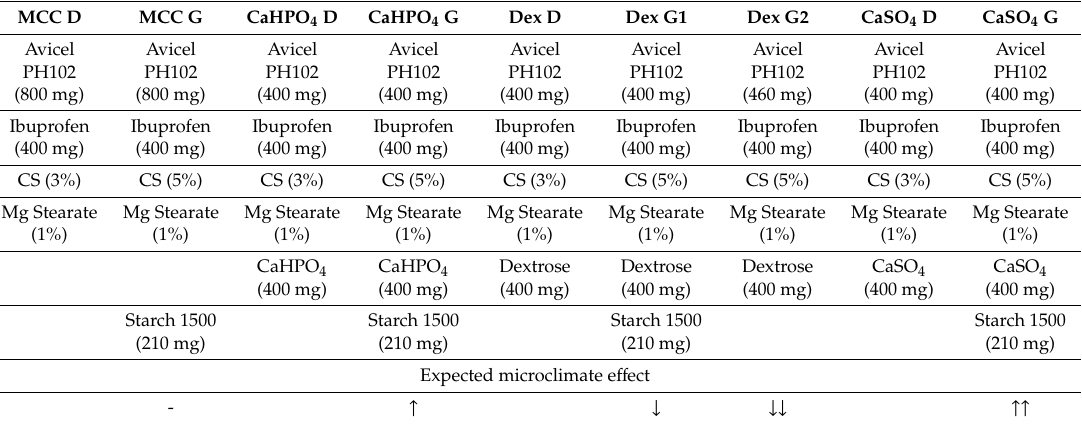
Table 1. Excipient composition of IR ibuprofen tablets prepared in-house. Formulations were named according to the diluent mixture